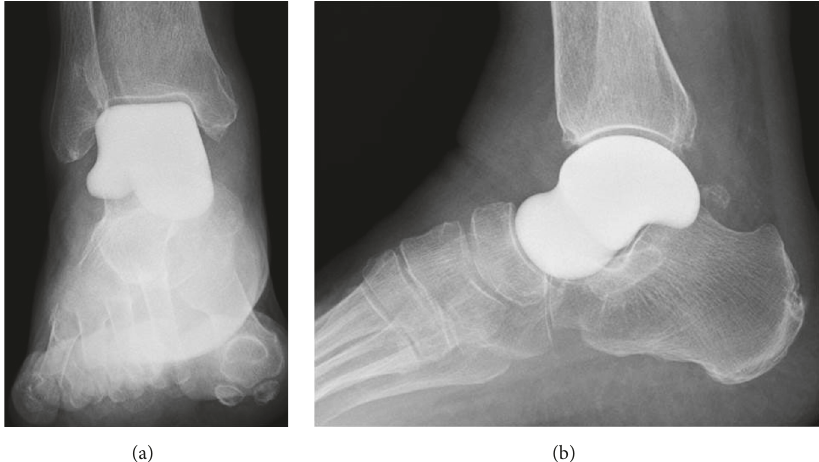
Figure 4: Postoperative radiographs showing the outcome of replacement of the talus with an alumina ceramic total talar prosthesis in anteroposterior (a) and lateral (b) views at 1 year and 6 months after surgery. There is good congruence between the talar prosthesis and the tibia, fibula, calcaneus, and navicular